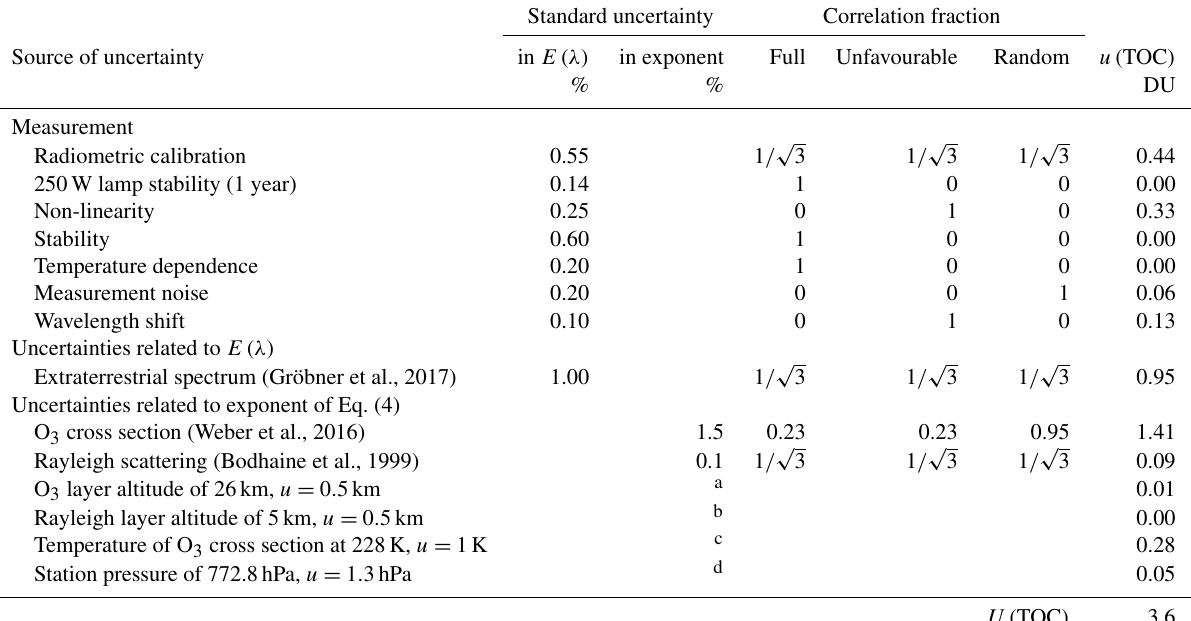
Table 4. An example uncertainty budget for QASUME spectroradiometer measured at local noon on the clear day of 17 September 2016. The last column states the standard deviations u( TOC ) corresponding to each individual uncertainty component for TOC = 284DU retrieved from the QASUME spectrum using the spectral range of 300–340nm at the solar zenith angle of 26.35 ◦ . The stated expanded uncertainty, U ( TOC ) = 3.6DU, was obtained by multiplying the combined standard uncertainty with a coverage factor k = 2. Standard uncertainty Correlation fraction Source of uncertainty in E(λ) in exponent